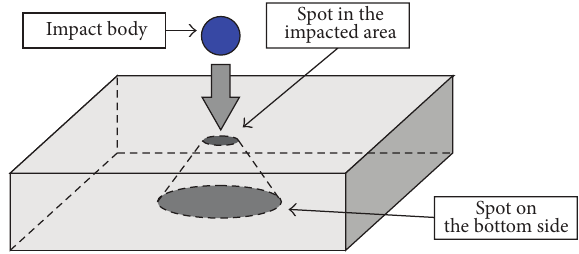
Figure 1: Outline of the damaged area of a composite plate after low energy impact loading